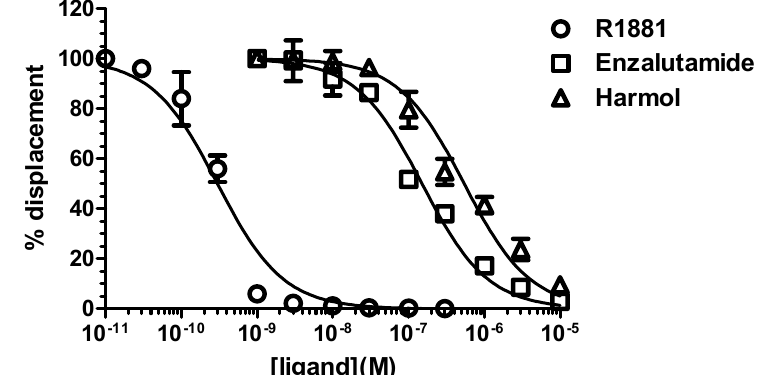
Figure 4. Harmol hydrochloride binds to AR. U2OS-hAR-ARE-Luc cells were incubated with 0.3 nM [ 3 H]-labeled R1881 at 37 °C for 3 h in the absence or presence of enzalutamide, harmol hydrochloride (0.01–10 µ M), or unlabeled R1881 (0.01–300 nM). Non-specific binding was determined in the presence of 300 nM unlabeled R1881. Specific binding was calculated by subtracting non-specific binding from total binding. Results were plotted as % of maximal [ 3 H]-labeled R1881 binding as a function of drug concentrations ( n = 3 ± SEM).